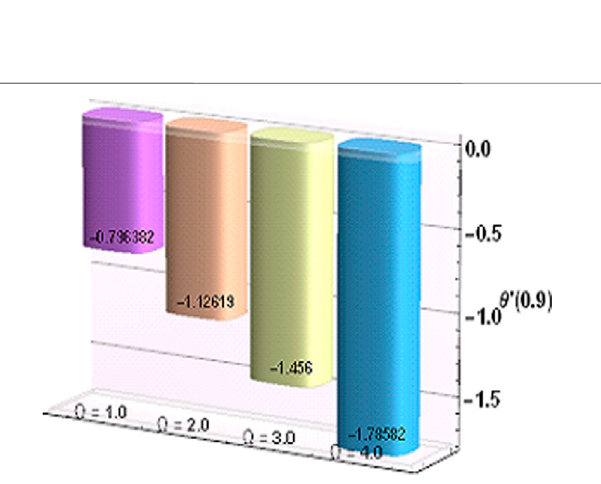
FIGURE24| Nusseltnumberforheatgenerationparameterwhen r → r 2